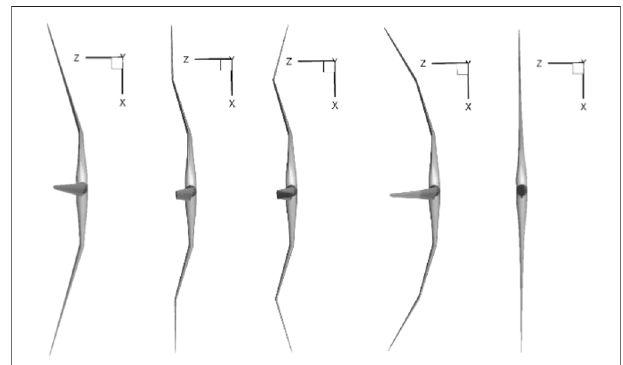
FIGURE1| Differentconningandpre-bendingcon fi